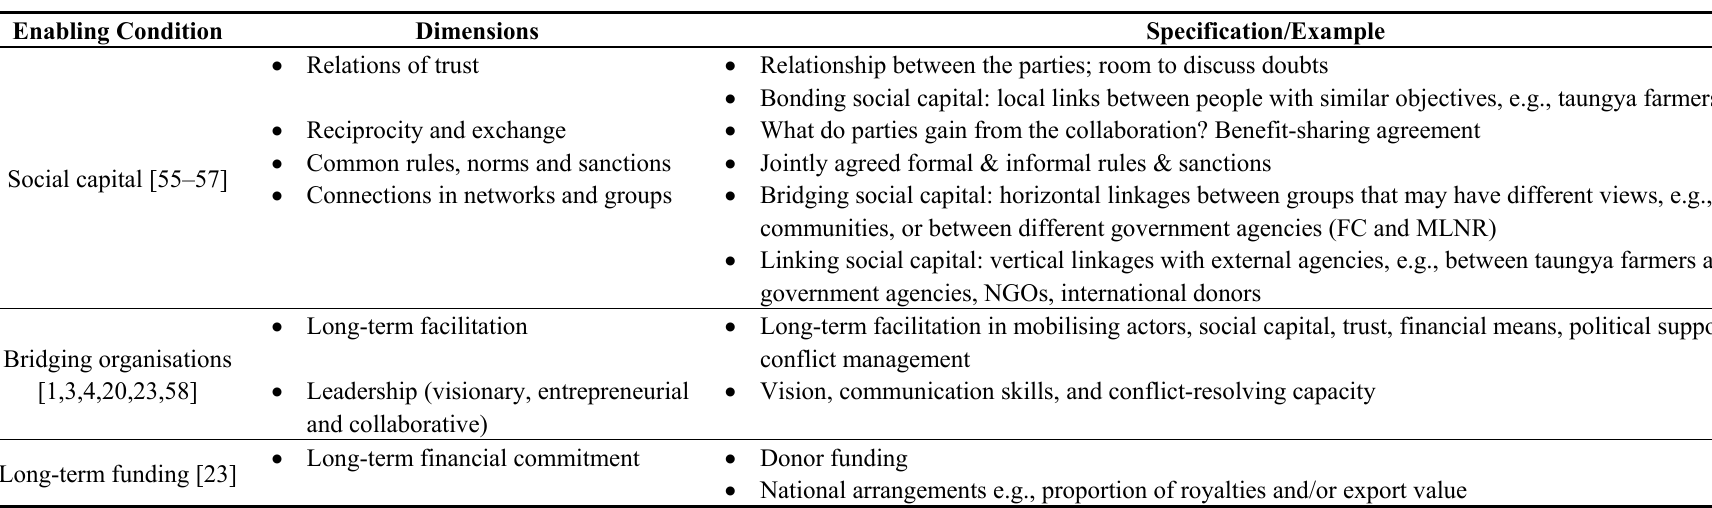
Table 3. Conditions enabling adaptive landscape